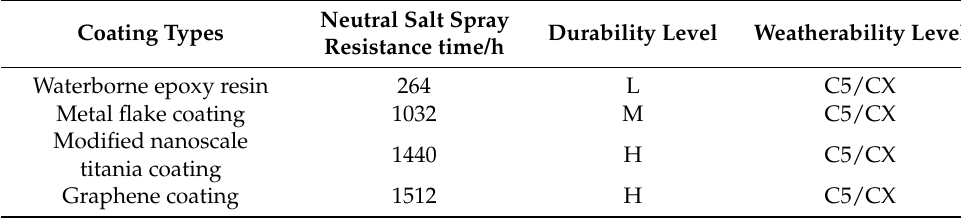
Table 2. Comparison of neutral salt spray resistance of different